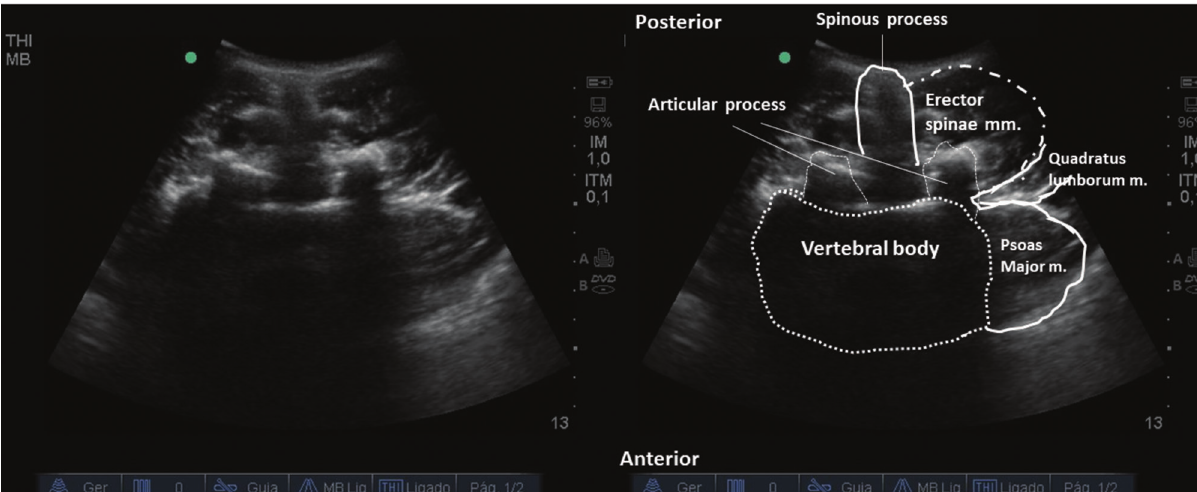
Figure 18 - US image of the transducer on the posterior midline in the transverse position. Spine vertebrae and important paravertebral structures for trans-muscular QL block.